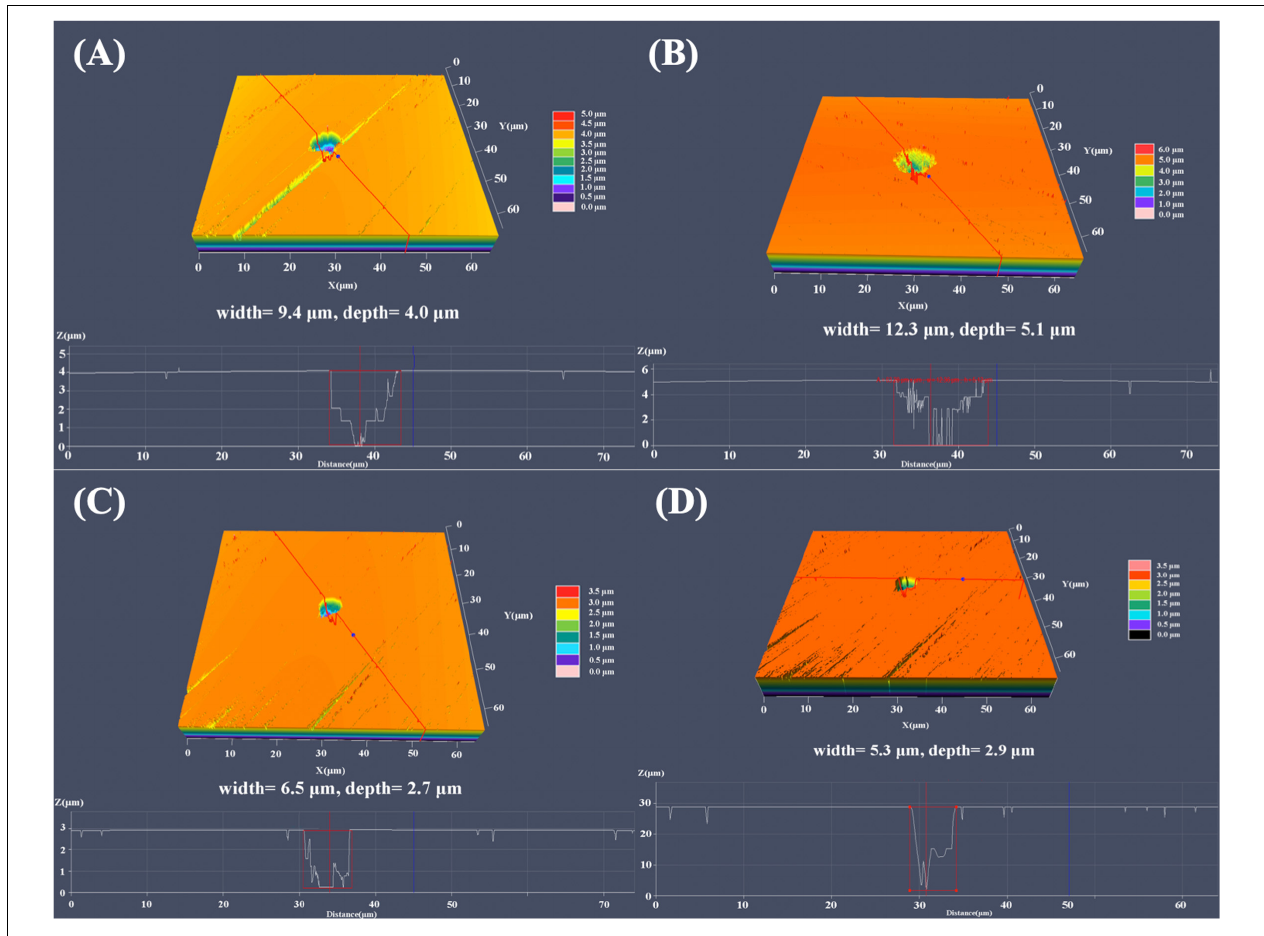
FIGURE 5 | Largest pit depth measured by CLSM of (A) 304L BM, (B) 304L WZ, (C) 304L-Cu BM, and (D) 304L-Cu WZ in the Pseudomonas aeruginosa -inoculated culture medium after 14 days. CLSM, confocal laser scanning microscopy; BM, base metal; WZ, welding